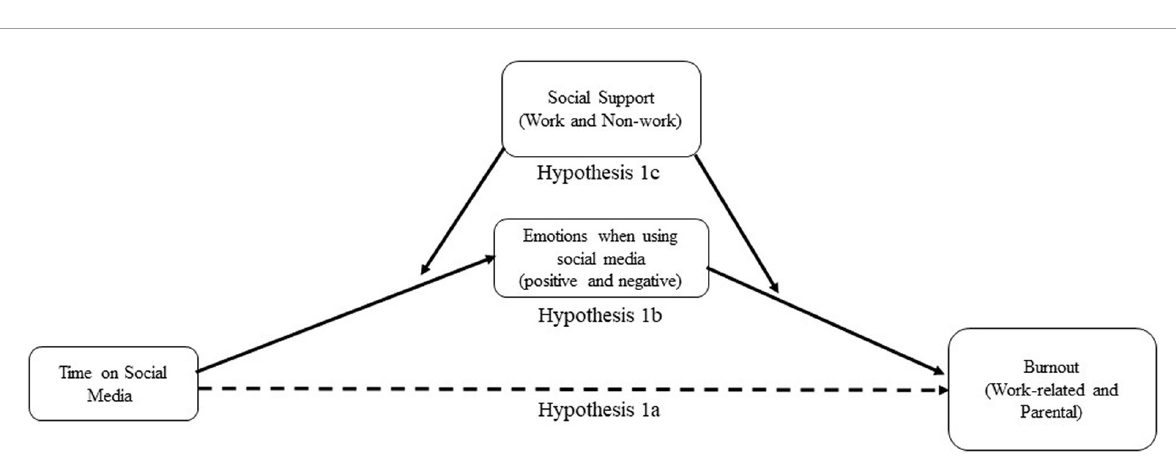
FIGURE2 Depiction of Hypothesis 2, where social comparisons interact with social support and do it all discrepancy to predict work-related and parental